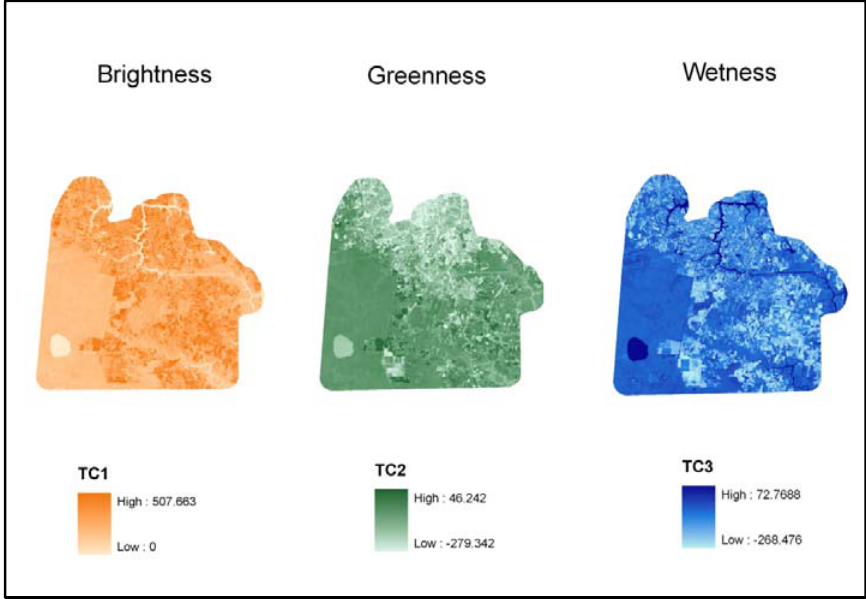
Figure 3. Derived Landsat-7 ETM+ Tasseled-cap indices for study area, brightness (TC1), greenness (TC2), and wetness